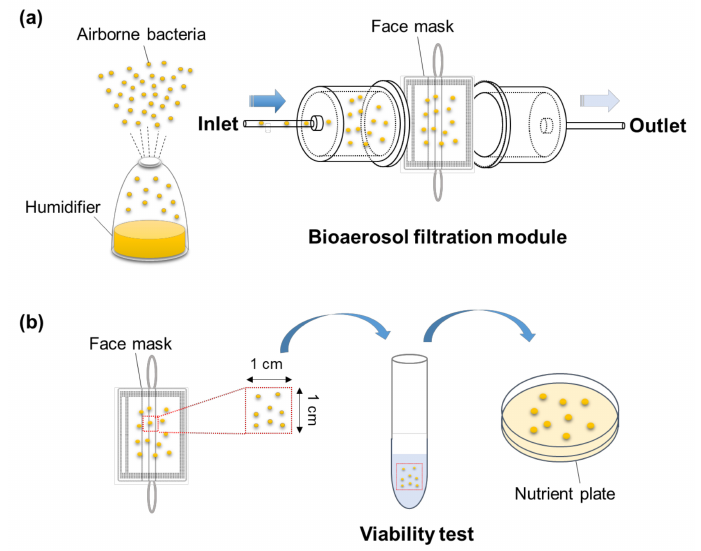
Figure 1. ( a ) Schematic illustration of a laboratory-scale system suitable for filtering airborne bioaerosols using face masks. ( b ) Experimental procedure used to perform viability tests for bioaerosols on face